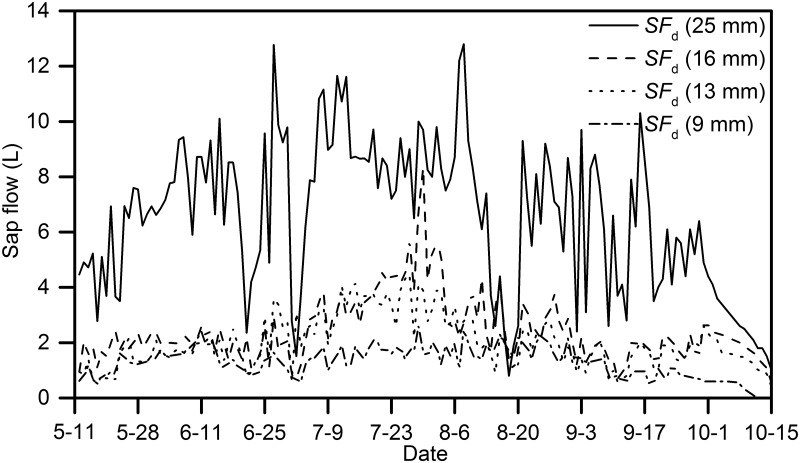
The seasonal variation of sap flow rate of H.scoparium (1st May–15th October 2011)